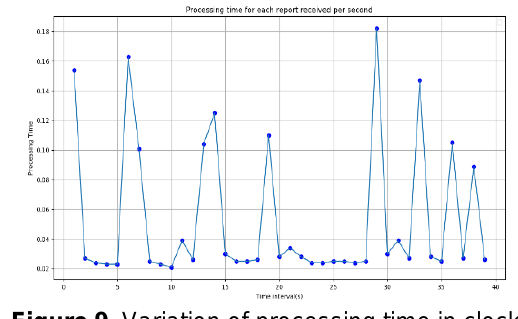
Figure 9. Variation of processing time in clock counts for the 1 second interval data.